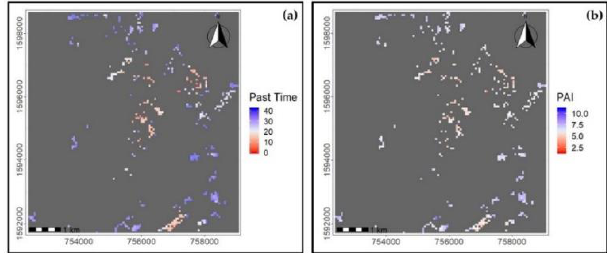
Figure 8. ( a ) Map showing the past time after disturbance of LTS sample plots. ( b ) Map showing the PAI values of LTS sample plots.